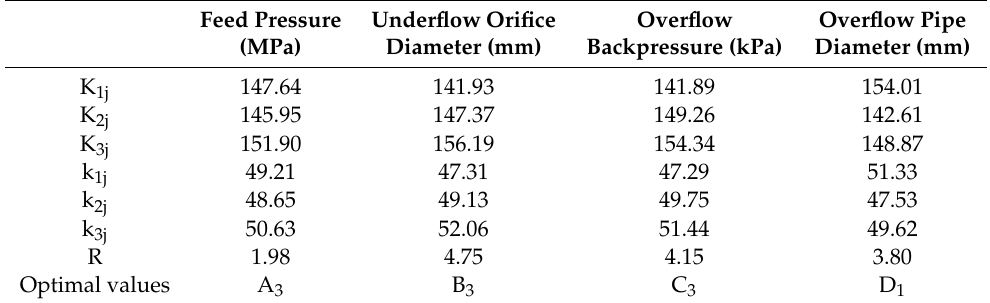
Table 13. Analysis of the orthogonal test data with the total separation efficiency as the response. Feed Pressure Underflow Orifice Overflow Overflow (MPa) Diameter (mm) Backpressure (kPa)